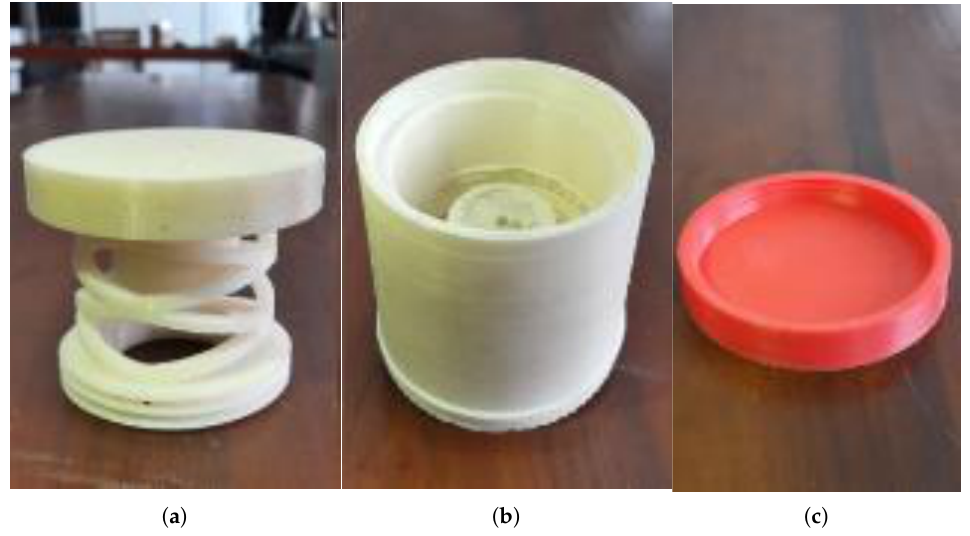
Figure 10. 3D printed parts of the force sensor: ( a ) cylindrical arch spring; ( b ) outer protection; ( c ) bottom